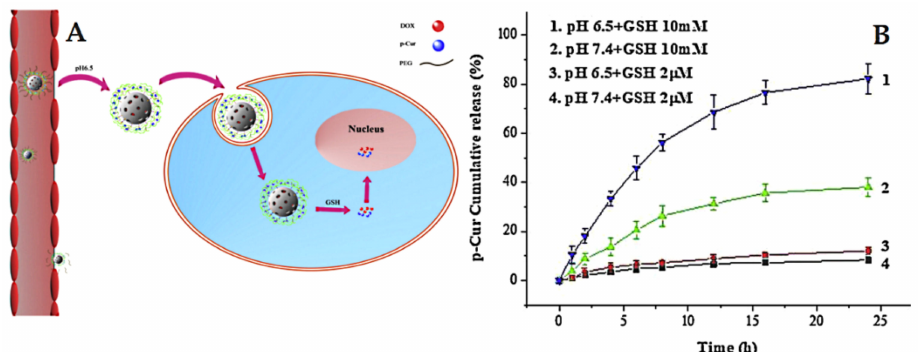
Figure 16. ( A ) Illustration of the dual-response release of p-Cur and Dox co-delivery. ( B ) In vitro release profiles of Cur from MSN/SP/bPEG at 37 ◦ C. Error bars indicate standard deviation. Repro- duced with permission from [228], Elsevier B.V,